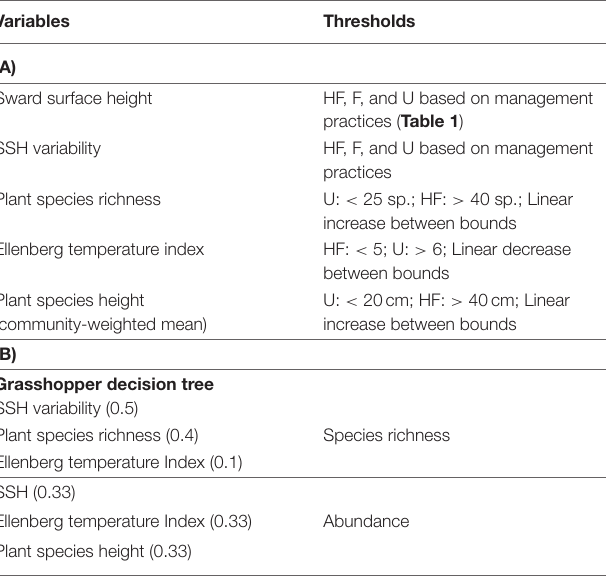
TABLE 5 | (A) Predictive variables, threshold levels, and (B) final decision tree of grasshopper abundance and species richness.